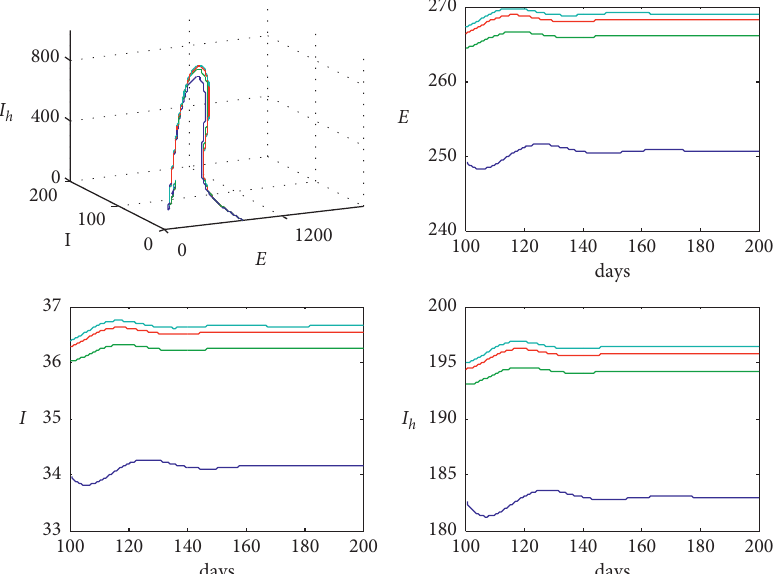
Figure 2: The trajectory of system (1), for the data given in Table 1 with different values of m , approaches to endemic point. The blue color for m � 0, green color for m � 100, red color for m � 200, and cyan color for m � 300.